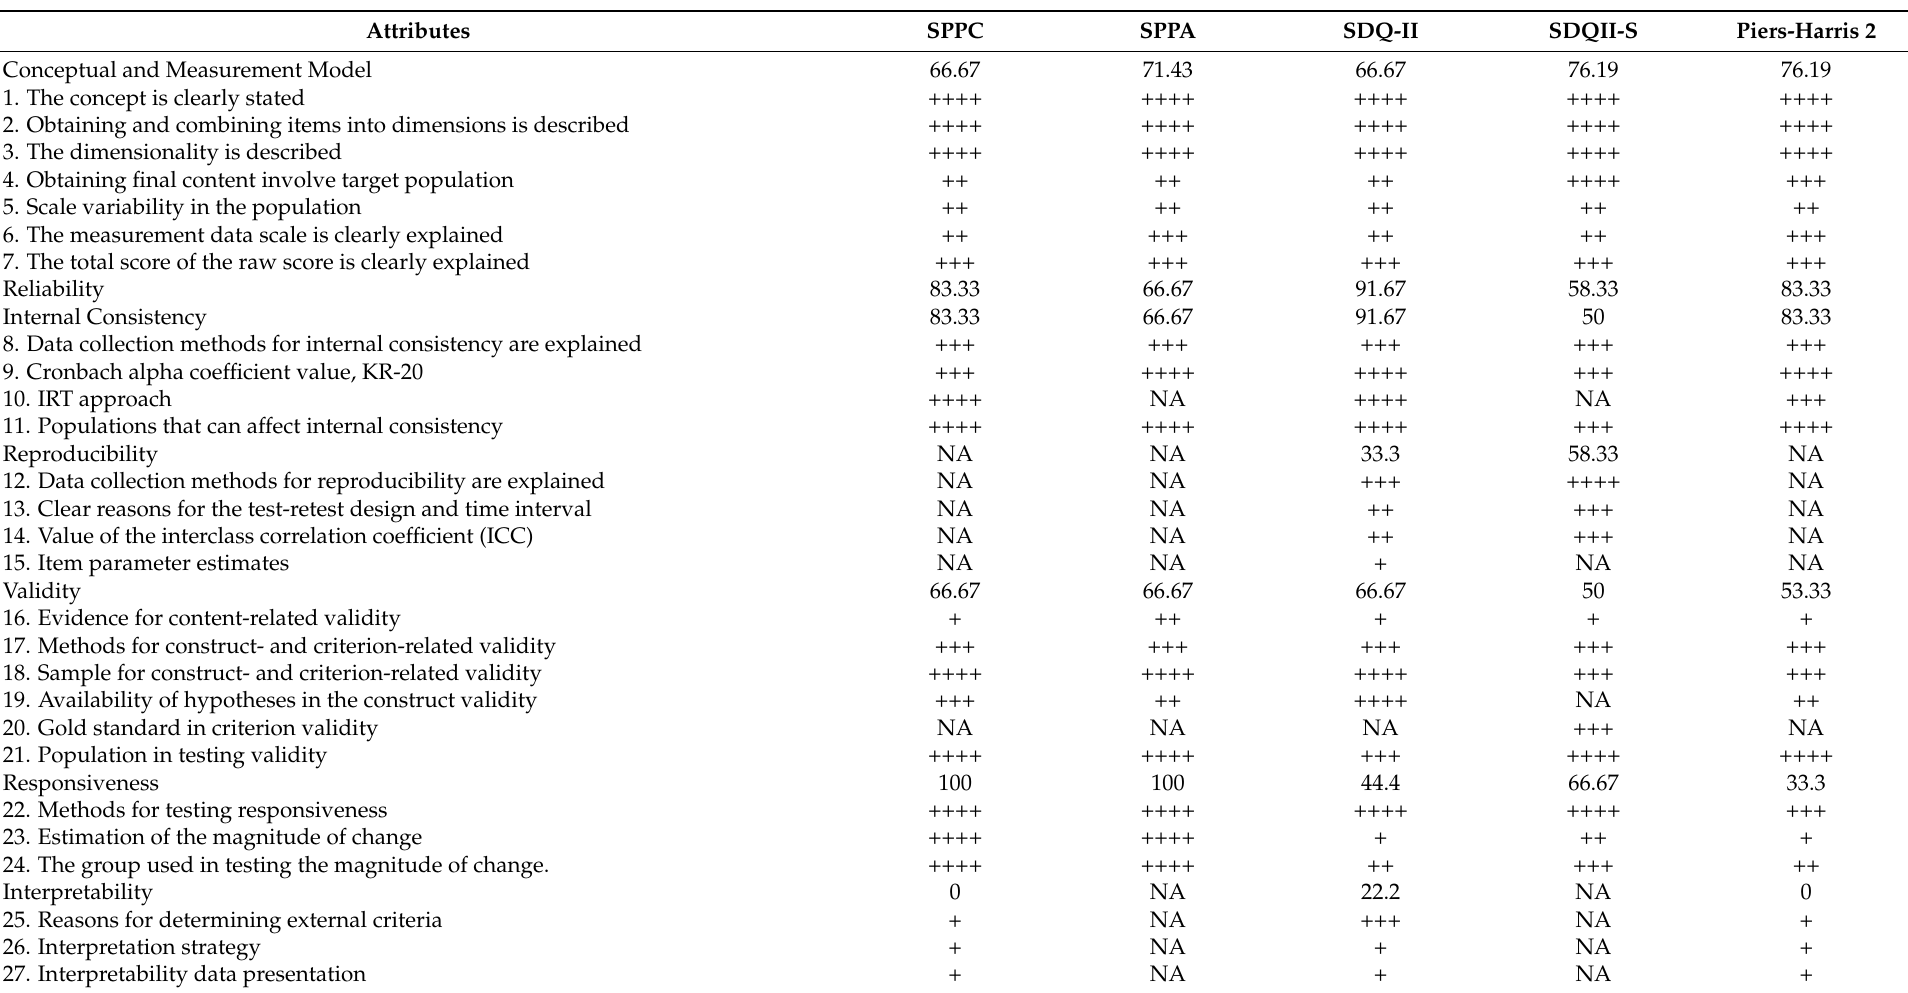
Table 3. Ratings of each EMPRO item and attributes for the instruments used to evaluate adolescents’